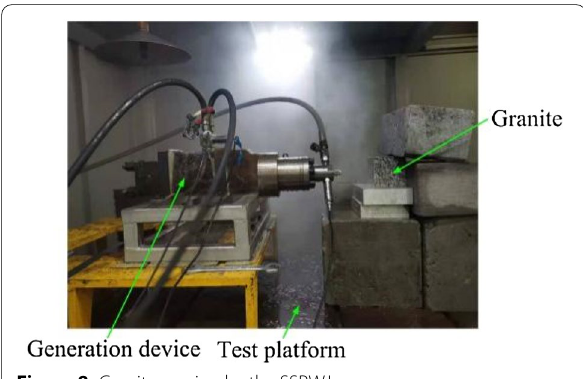
Figure 8 Granite erosion by the